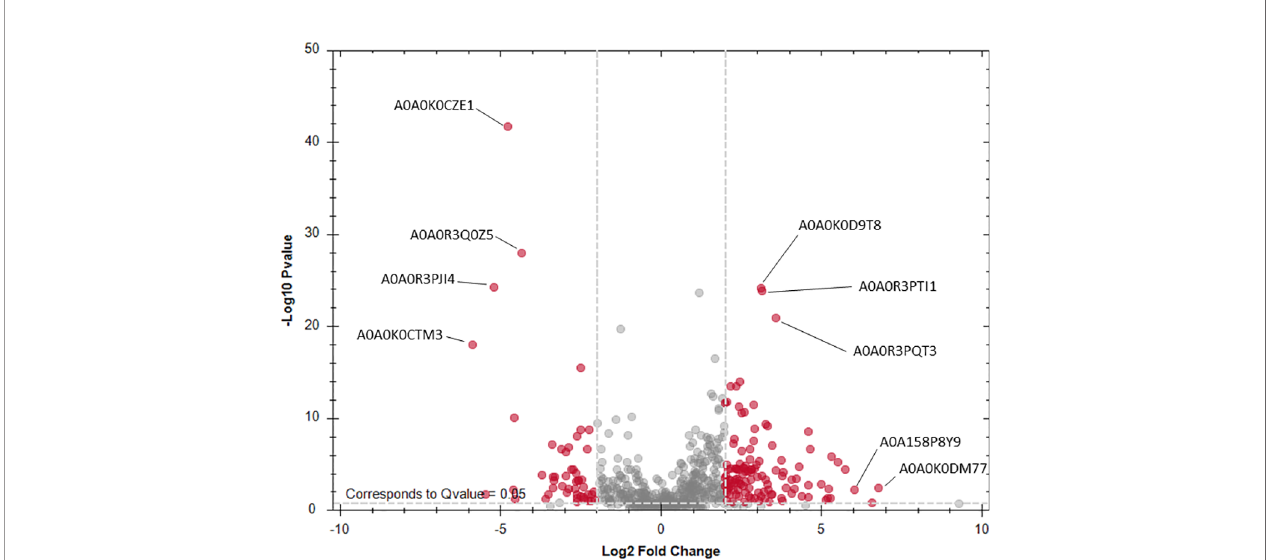
FIGURE 3 | Volcano plot of differentially expressed excretory/secretory proteins of Angiostrongylus vasorum obtained by comparing males vs. females. Female ESP: A0A0K0CZE1, A0A0R3Q0Z5, A0A0R3PJI4, A0A0K0CTM3 (orthologue description ‘ von Willebrand factor type D domain protein ’ ) Male ESP: A0A0K0D9T8 (orthologue description ‘ Kunitz/Bovine pancreatic trypsin inhibitor domain protein ’ ); A0A0R3PTI1 (orthologue description ‘ Hsp90 protein ’ ); A0A0R3PQT3 (orthologue description ‘ PKS_ER domain-containing protein ’ ); A0A0K0DM77, A0A158P8Y9 (orthologue description ‘ MSP domain protein ’ ). Orthologue descriptions obtained from